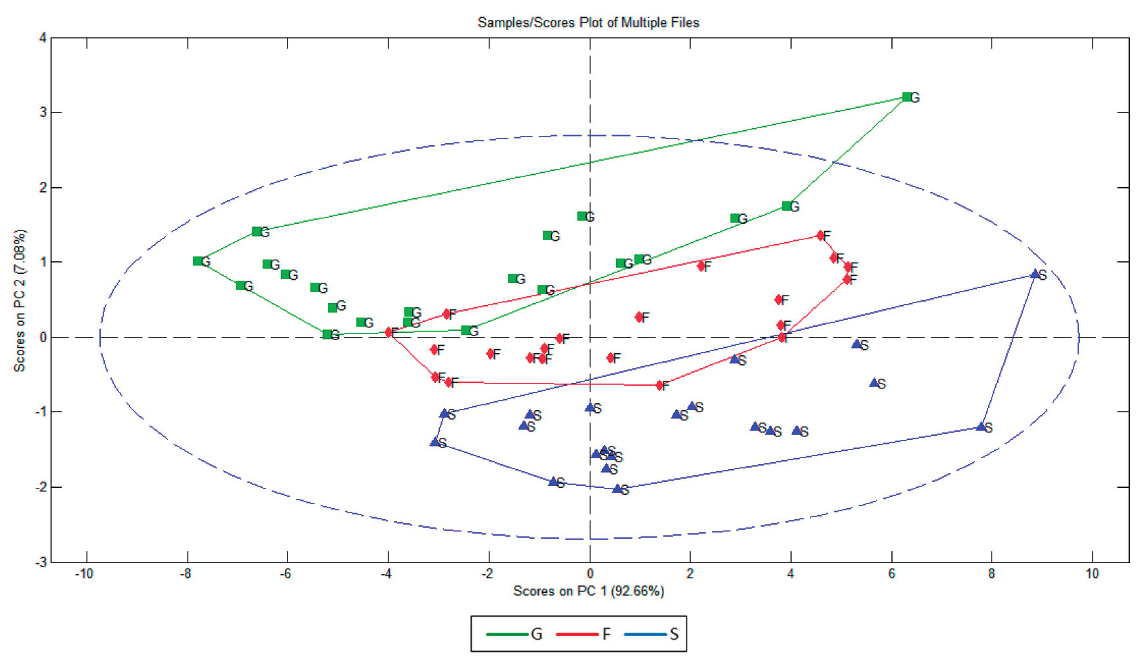
Figure 7. Principal component analysis (PCA) for the studied fermentable sugars: glucose (G), fructose (F) and sucrose